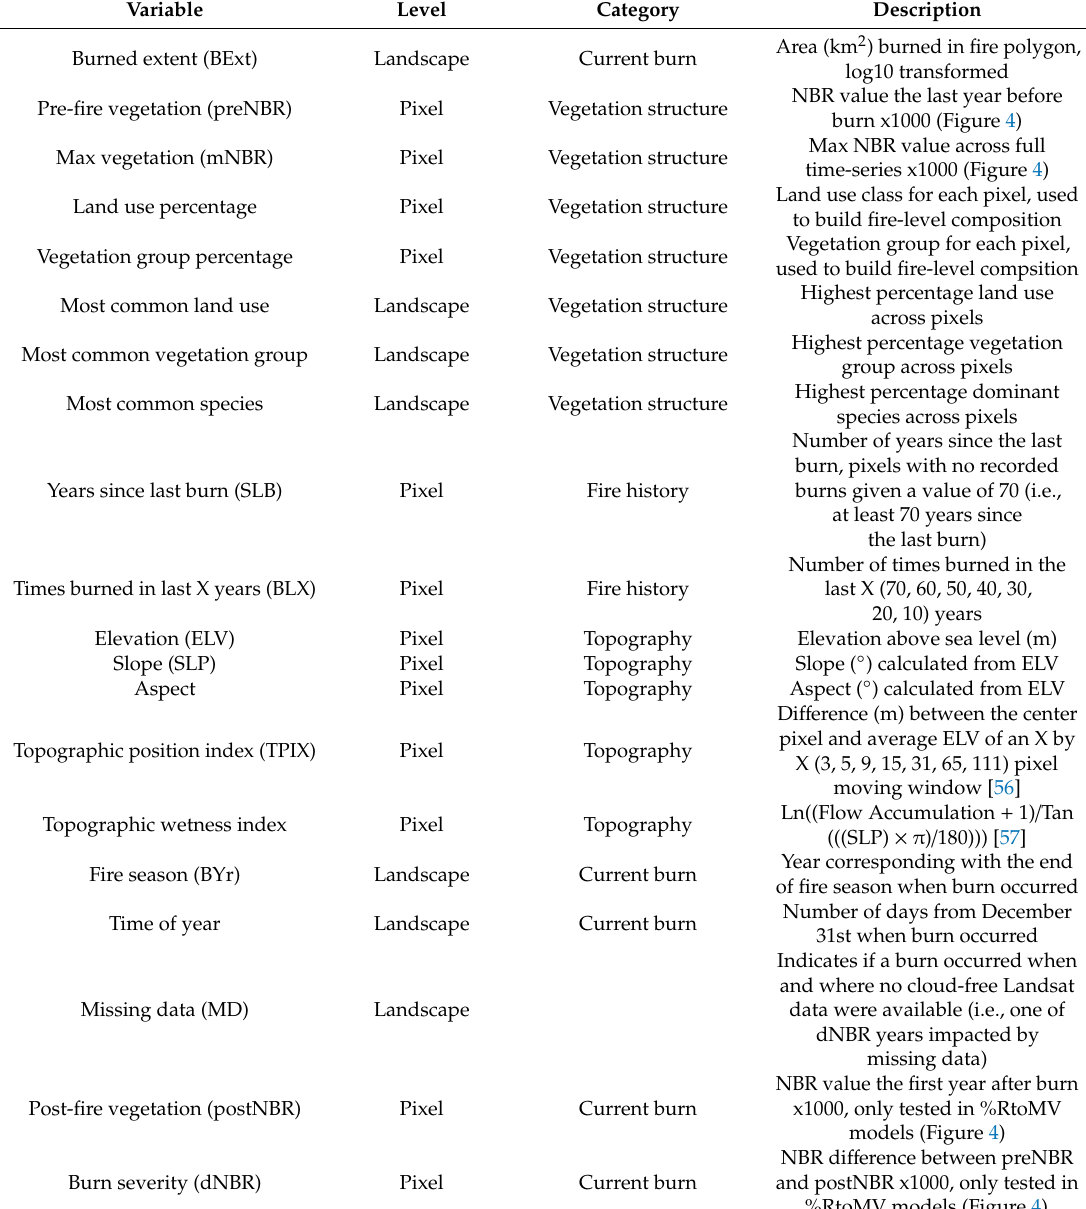
Table 3. Descriptions of variables tested for influence on burn severity ( dNBR ) and recovery (